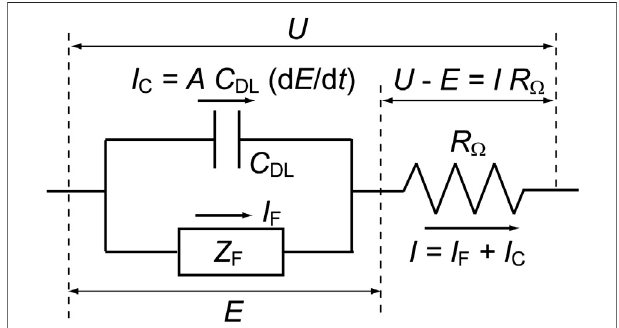
FIGURE 3 | The equivalent circuit from which the time dependence of the true electrode potential (d E/ d t ) is derived. The total current from the electrode ( I ) is the sum of the Faraday current ( I F ) and the charging current of the electric double layer at the electrode surface ( I C ). Here, U is the applied potential, E the true electrode potential, A the electrode area, Z F the Faraday impedance, C DL the double layer capacitance, and R Ω the solution resistance between the working and reference